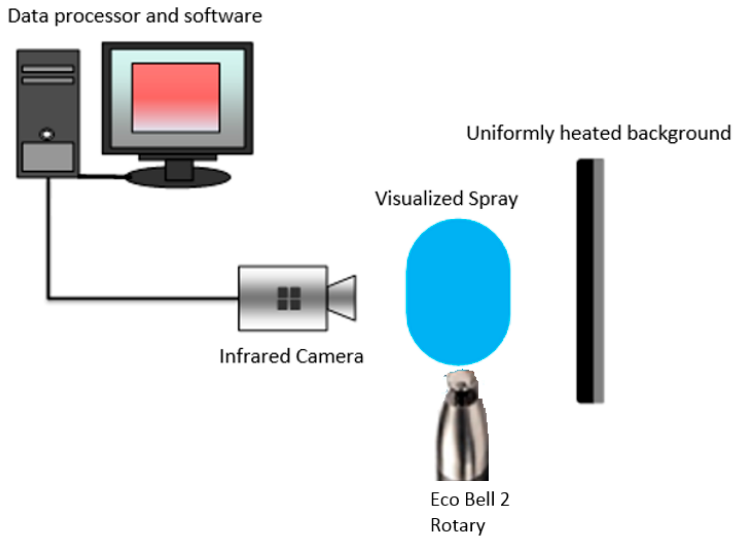
Figure 2. Schematic of the experimental setup.